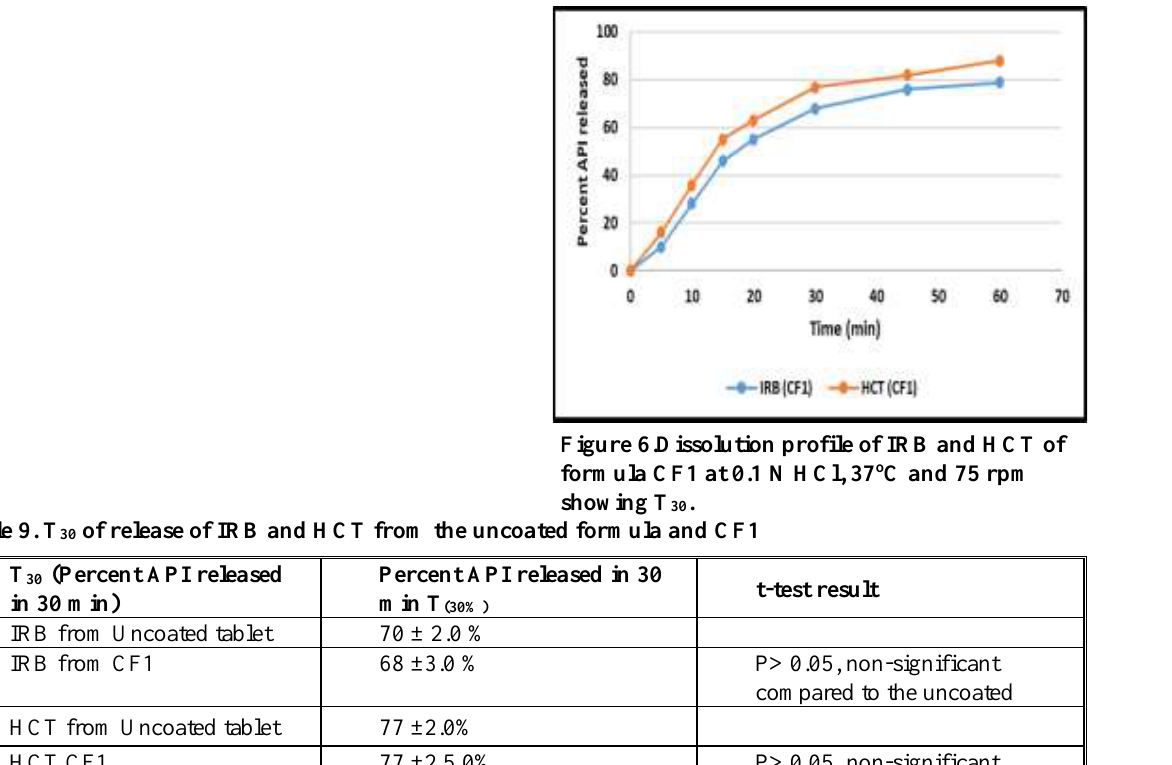
Figure 5.Dissolution profile of IRB and HCT of uncoated tablets at 0.1 N HCl, 37 o C and 75 rpm showing T 3.